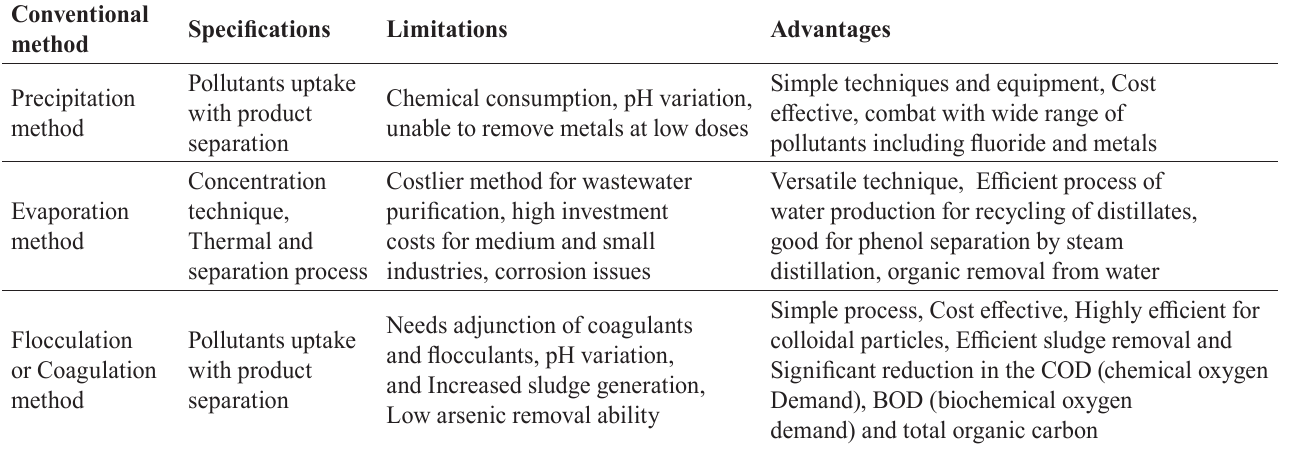
TABLE II - Summary of conventional and traditional methods of wastewater treatment